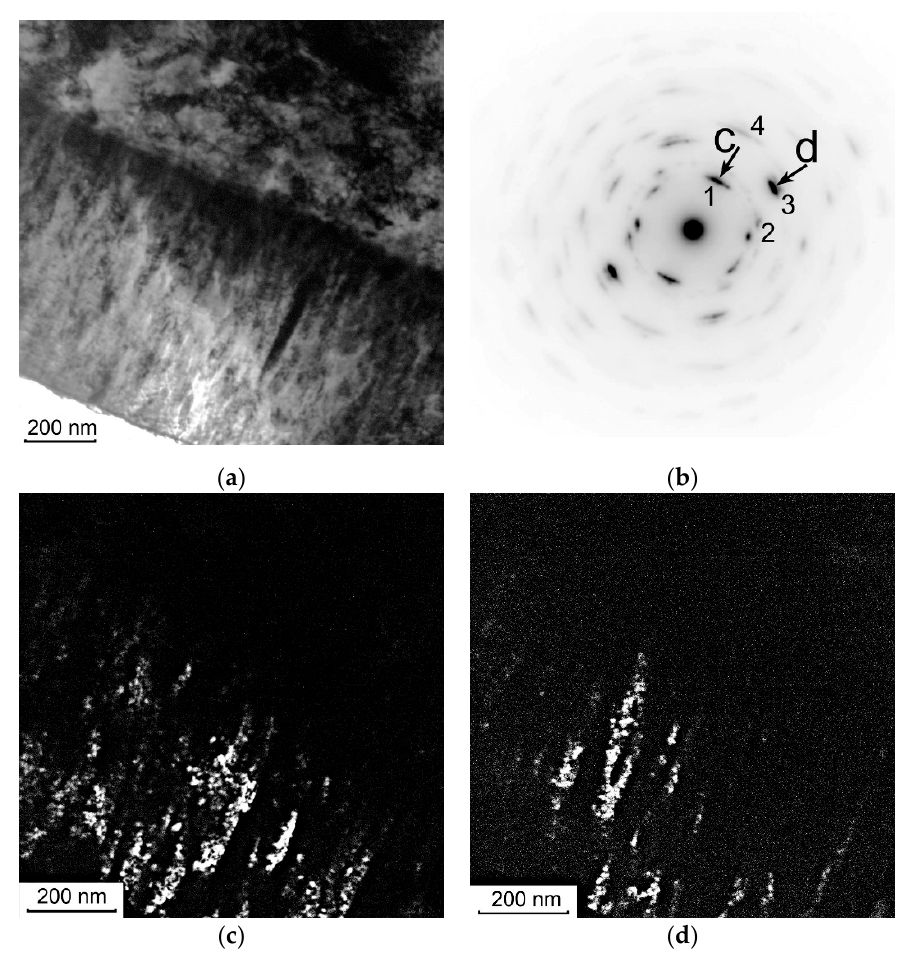
Figure 3. Bright-field ( a ) microstructural image (TEM) of the (Ti,Zr)N coating from the TZ2SMC specimen; microdiffraction pattern ( b ) from the central area of the coating (reflections of quasi-rings of the following types are indicated: 1—(111), 2—(200), 3—(220), 4—(222)); dark-field images ( c , d ) of the coating microstructure (reflections of the (111) and (220) type are indicated in Figure 3b by arrows).